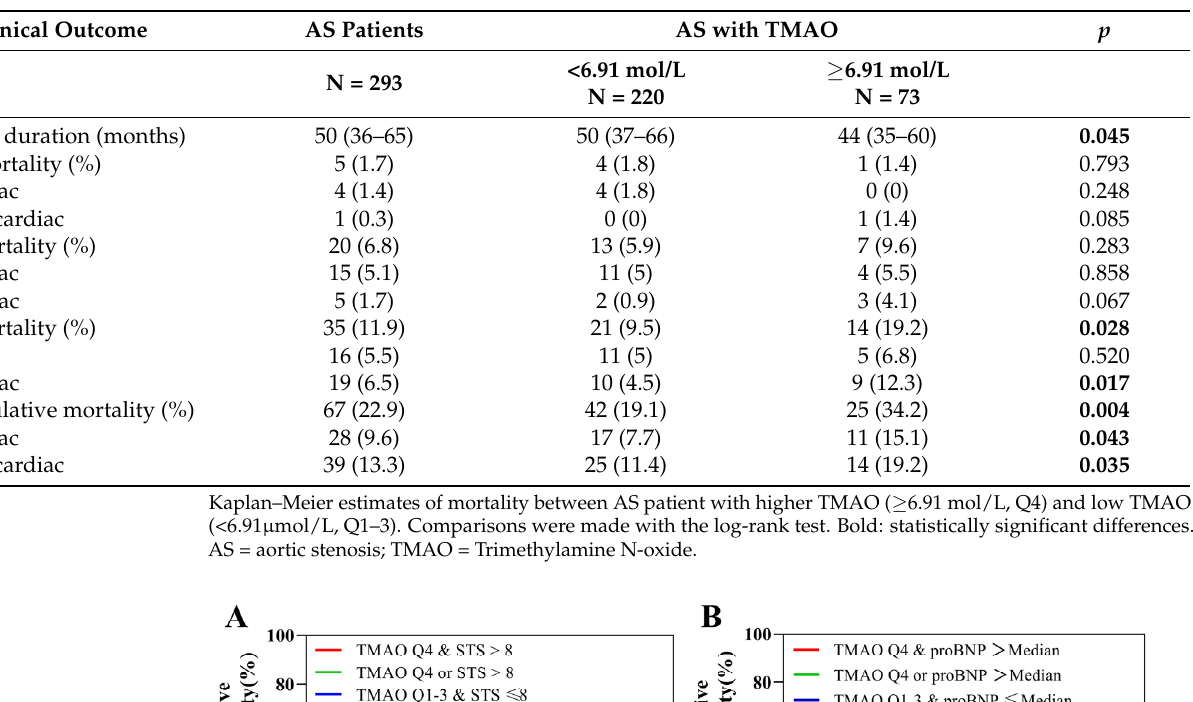
Figure 2. Late cumulative and 2-year event rate of mortality according to elevated TMAO. Kaplan– Meier analysis of late cumulative all-cause mortality ( A ), cardiac mortality ( B ), and non-cardiac mortality ( C ) stratified by TMAO levels in AS patient after TAVR. TAVR = transcatheter aortic valve replacement. TMAO = Trimethylamine N-oxide. Table 3. Clinical outcome of patients after TAVR according to quartiles of TMAO (Q4 vs. Q1–3). Clinical Outcome AS Patients Kaplan–Meier estimates of mortality between AS patient with higher TMAO ( ≥ 6.91 mol/L, Q4) and low TMAO (<6.91 μ mol/L, Q1–3). Comparisons were made with the log-rank test. Bold: statistically significant differences. AS = aortic stenosis; TMAO = Trimethylamine N-oxide.